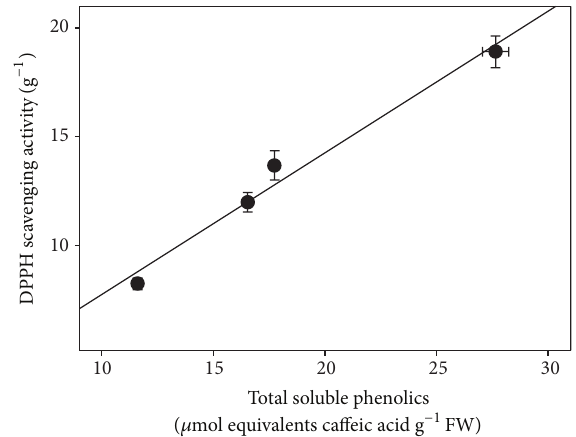
Figure 4: Effect of BA concentration on C. heterophyllus shoot multiplication rate after 4 weeks of culture in MS/2 liquid media supplemented with 0.0, 0.1, 1.0, and 5.0 mgL −1 BA. Vertical bars represent means ± standard error.